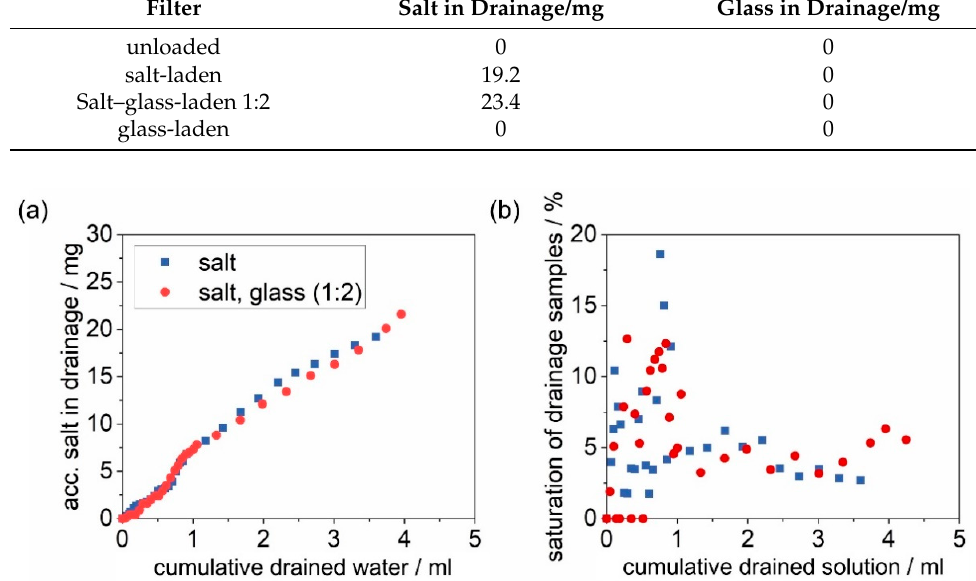
Figure 15. Results of the gravimetrical analysis of the drainage of a salt-laden (initially loaded with 131 mg salt) and a salt–glass-laden filter (initially loaded with 131 mg salt and 262 mg glass), where time = 0 marks the start of the drainage: ( a ) the accumulated salt per cumulative drained water and ( b ) the saturation of drainage samples.